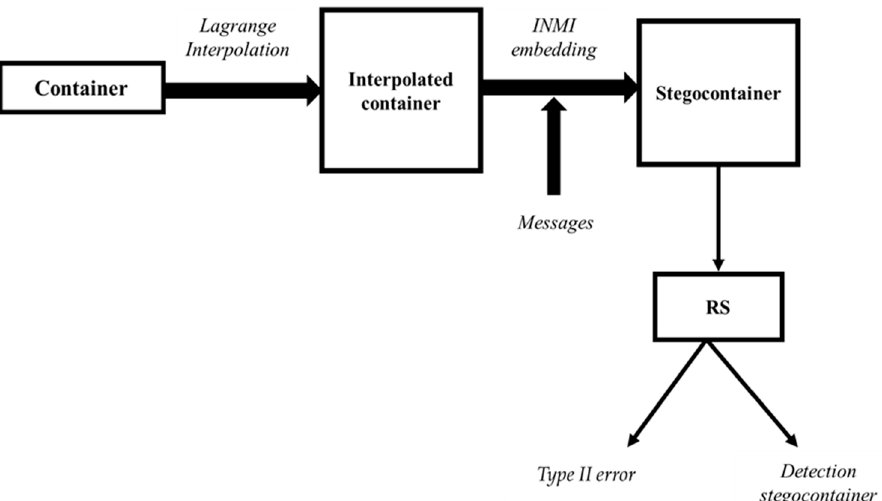
Figure 2. Scheme of experimental studies.